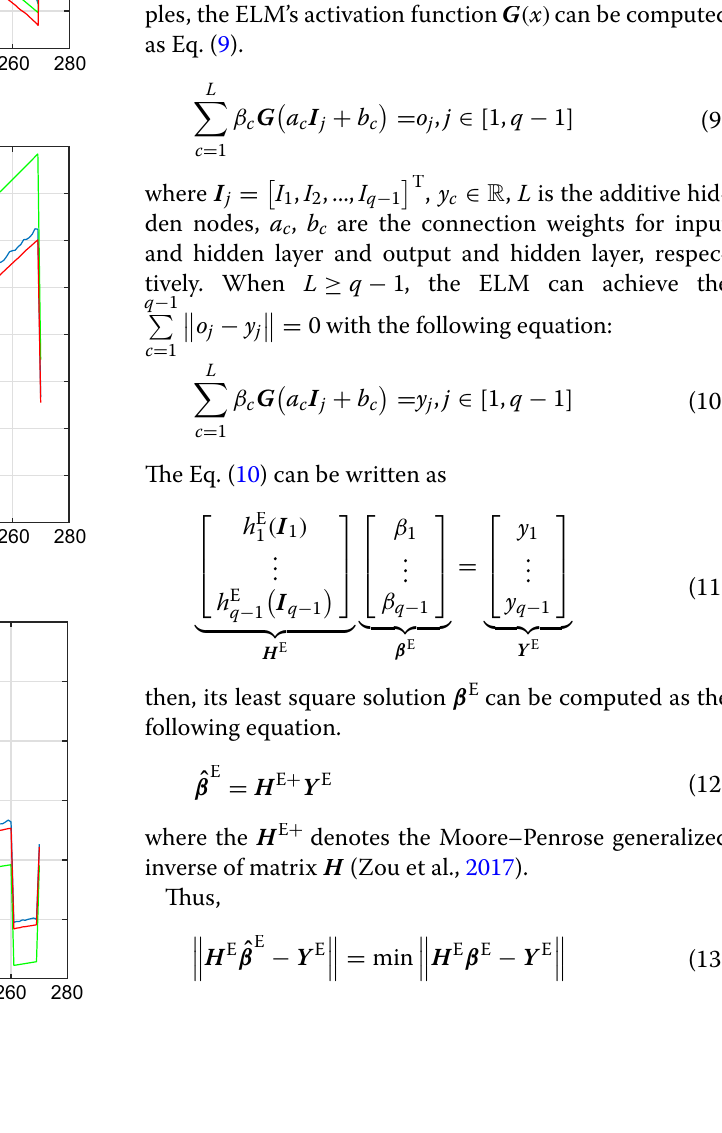
ELM Base on the model (1)(4) and the scheme proposed in Section , the ELM method used in this work is intro- duced in this subsection, which was introduced briefly in Zou et al. (2017). With the q − 1 arbitrary distinct sam- ples, the ELM’s activation function G ( x ) can be computed as Eq. (9).